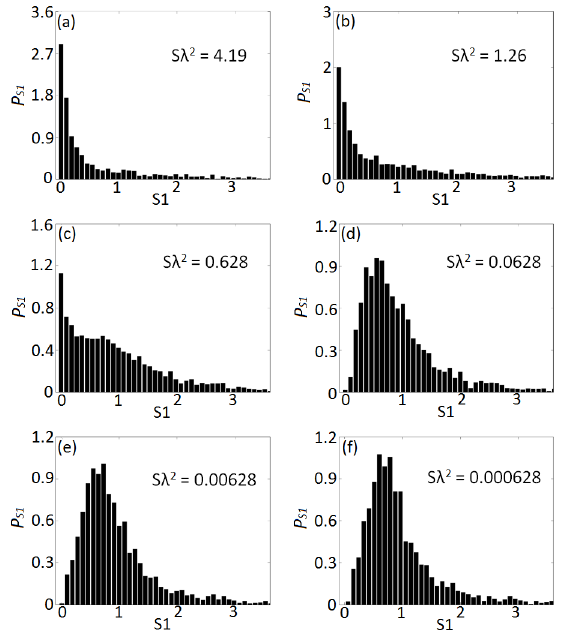
Figure 16. Level statistics of first-neighbor eigenvalues in the complex plane for an N = 1000 π -spiral array with S λ 2 values as indicated in the panels. The value of first level spacing, S 1 , is computed at the nearest neighbor distance between eigenvalues in the complex plane for each eigenvalue, and is normalized by the average S 1 for each case. The probability density is normalized such that the total probability equals to